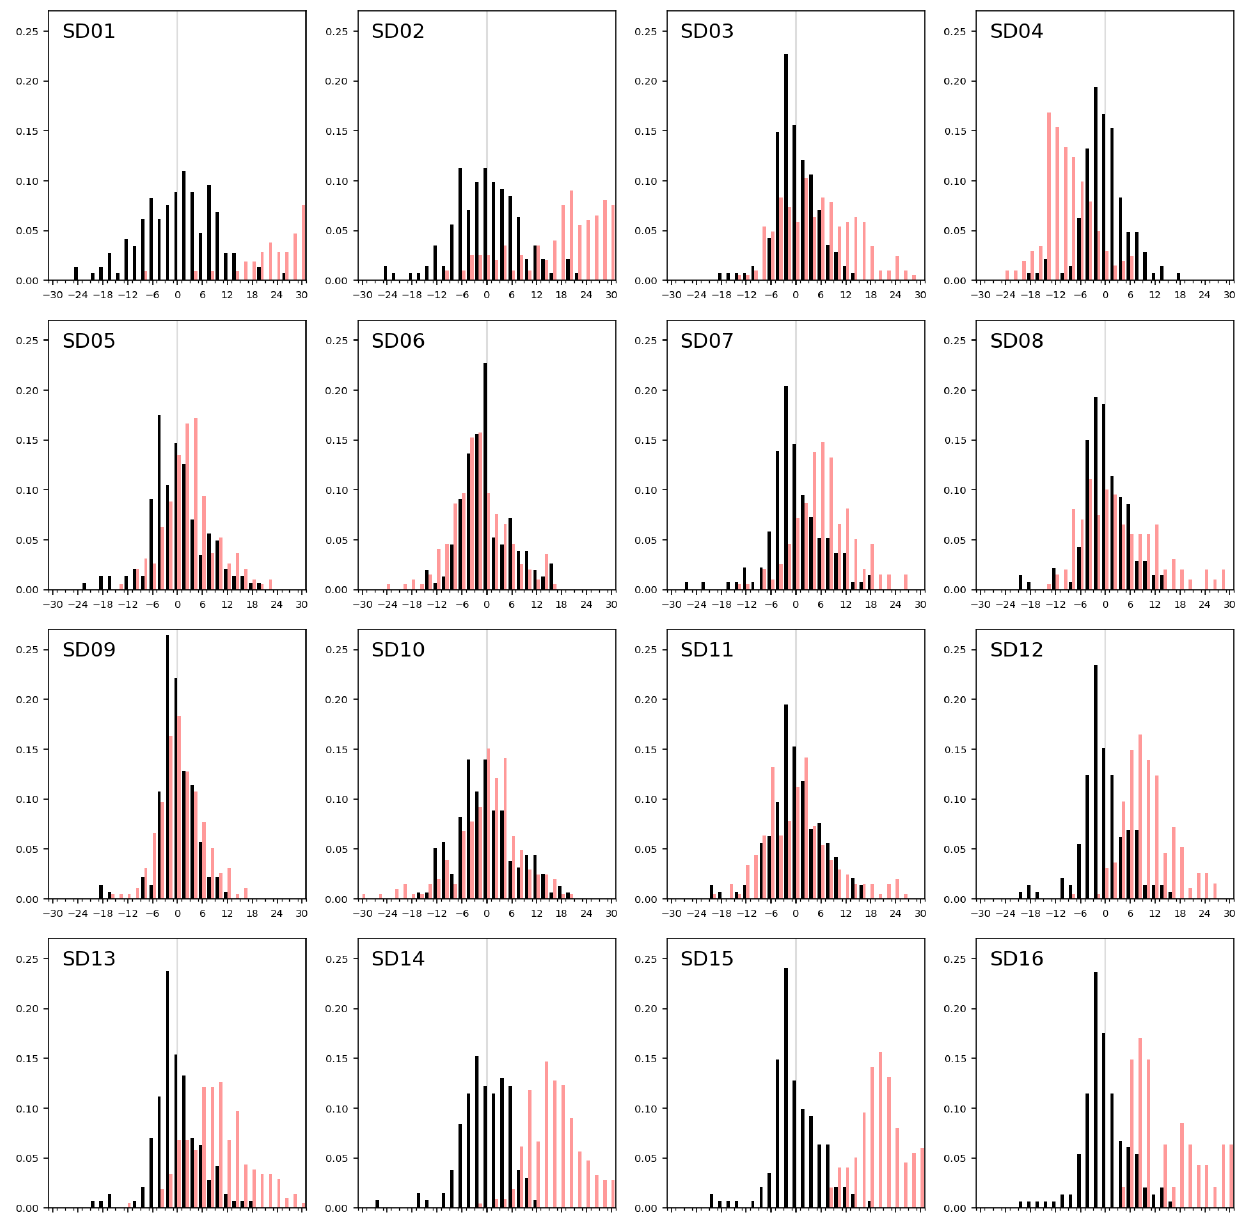
Figure 8. Sensor drift during 2 months of operation, shown as the distribution of residuals (in 2µgm − 3 bins) with the reference measurements during the first calibration period (black bars) and during the second period (red